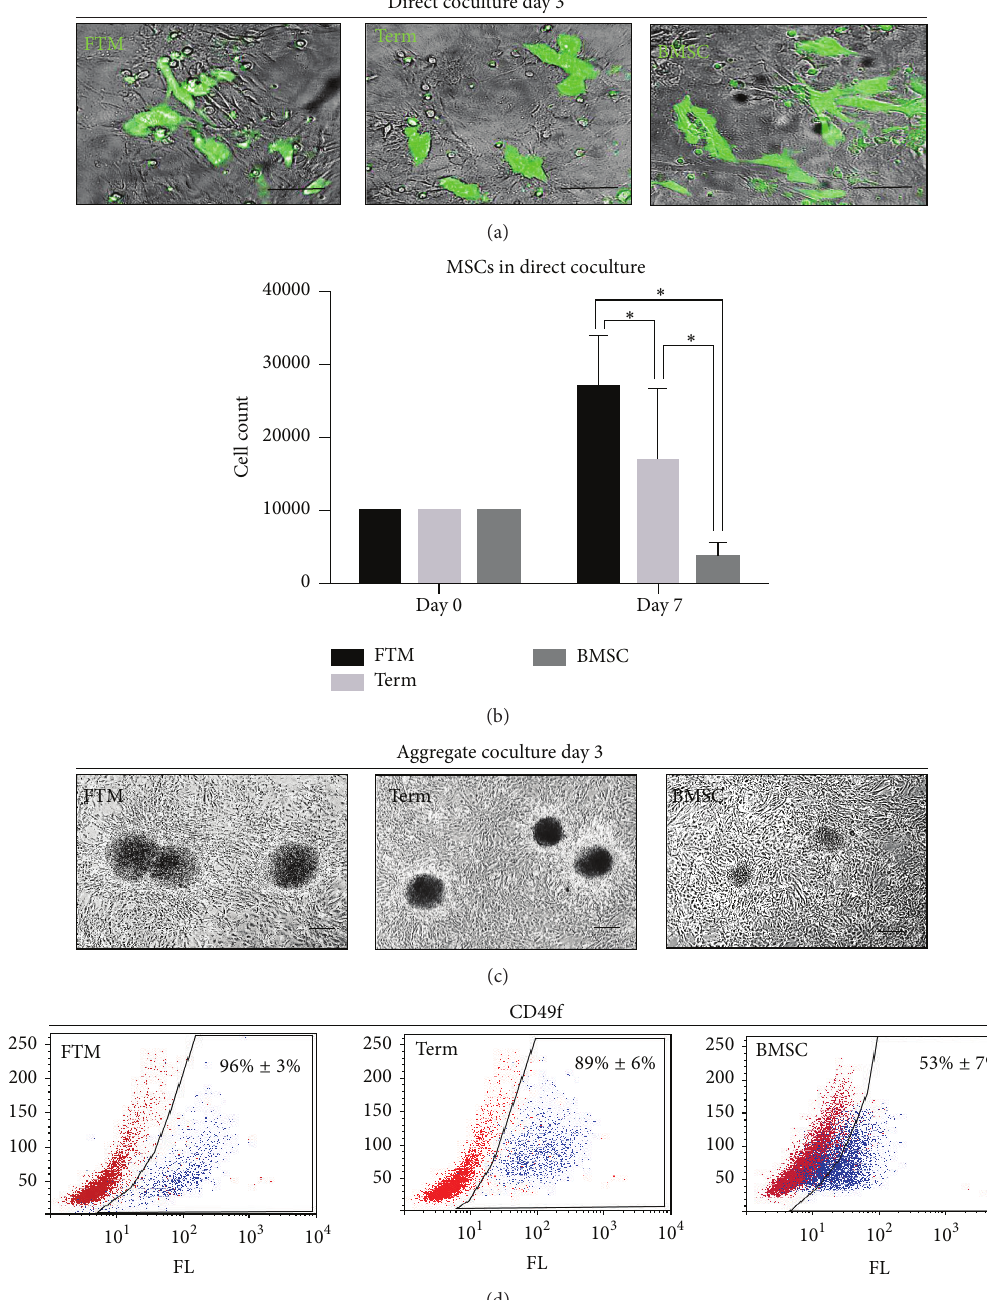
Figure 1: Cardiomyogenic induction of hMSCs using primary rat cardiomyocyte coculture strategies. (a) Bright field, fluorescent microscopy (green) overlay of direct cocultures from prestained human MSCs (CellTracker Green) and rat primary cardiomyocytes at day 3. Bar = 100 𝜇 m. (b) Cell counts of human cells (TRA-1-85 high ) extracted from hMSC, rat cardiomyocyte cocultures at day 7, compared to initial cell counts (day 0). (c) Bright field microscopy images of hMSC aggregate cocultures. (d) Flow cytometry analysis: CD49f-positive populations in undifferentiated MSC cultures. FTM: first trimester HUCPVC; term: term HUCPVC; BMSC: human bone marrow mesenchymal stem cell. Bar = 200 𝜇 m. ∗ 𝑝 ≤ 0.01